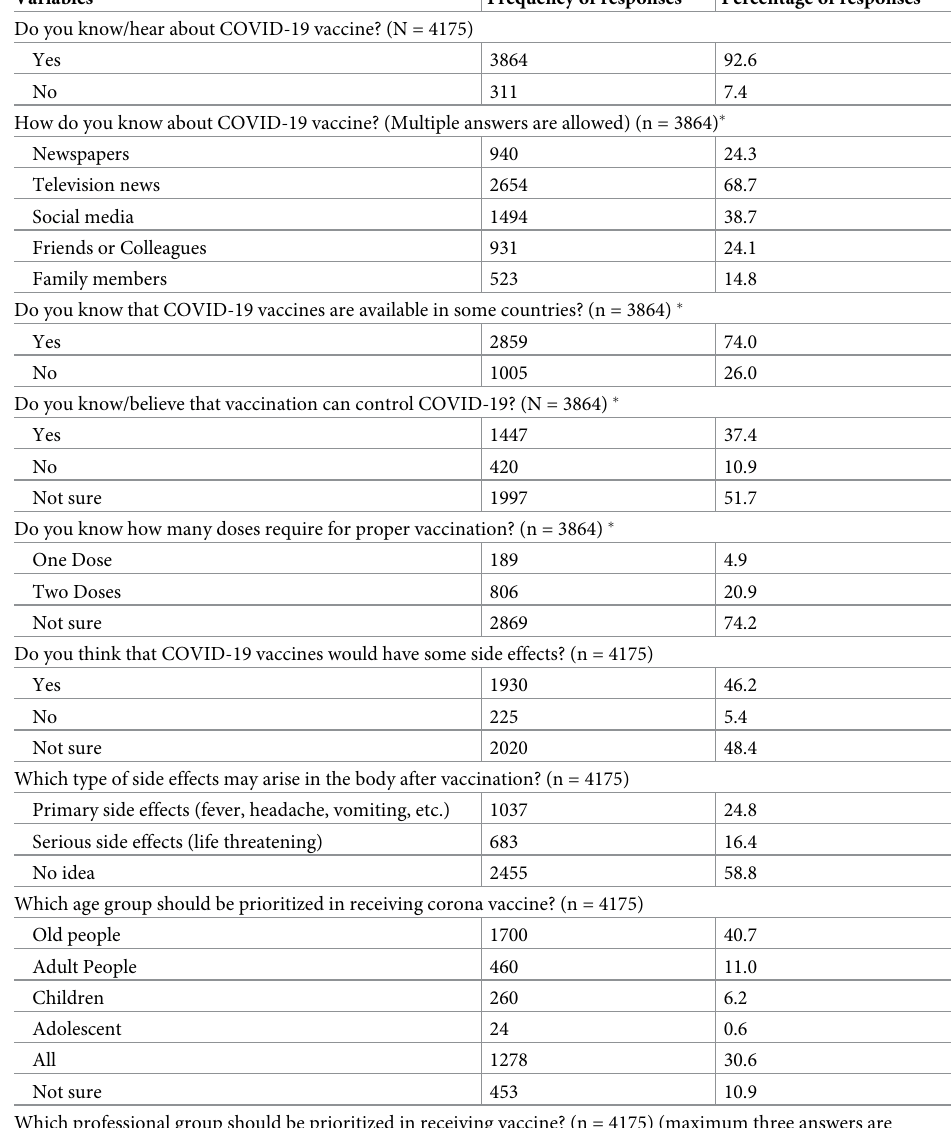
Table 2. Respondents’ knowledge on COVID-19